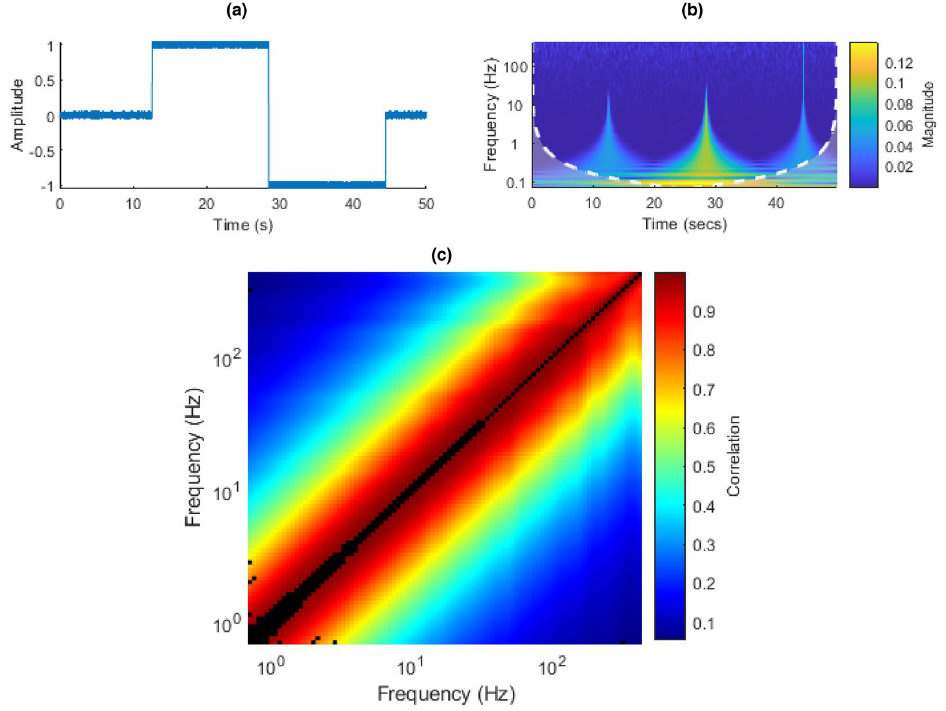
Figure 16. ( a ) Square-wave time domain plot. ( b ) Square-wave CWT. ( c ) Square-wave ISPCM, black elements represent non-statistically significant correlations at an FDR α of